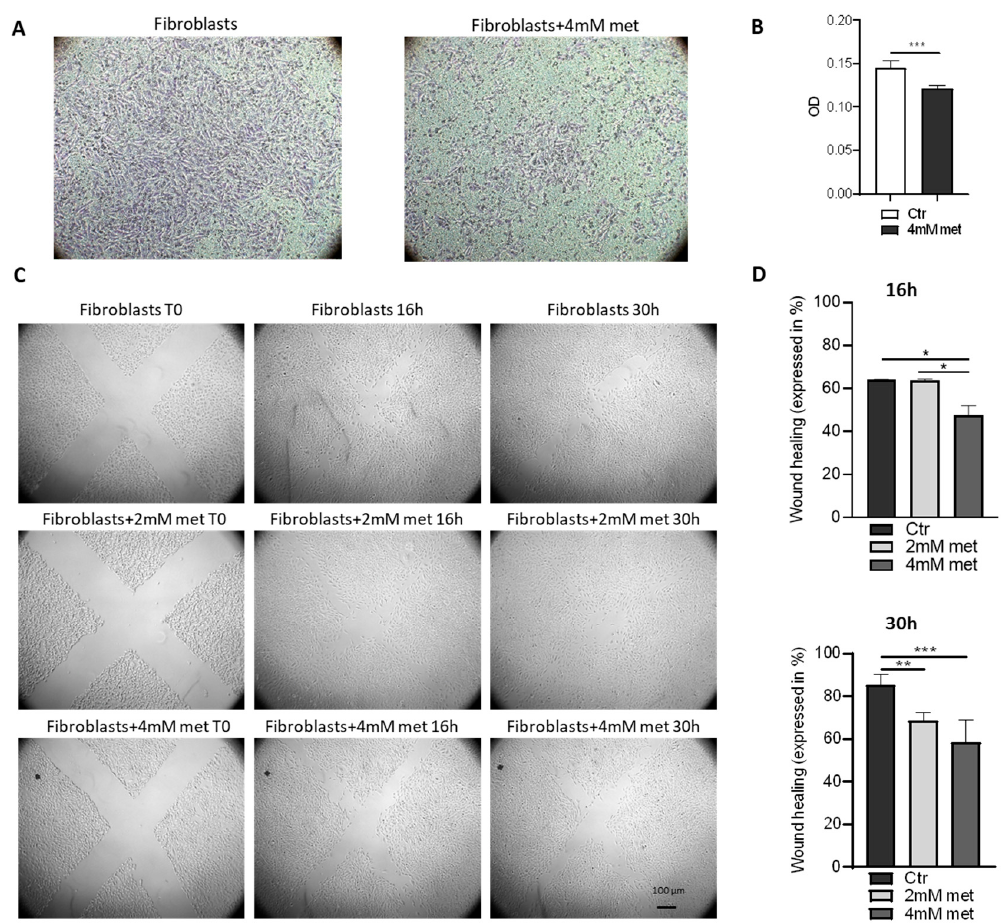
Figure 6. Effects of metformin on fibroblasts migration. ( A ) Fibroblast migration through 8 µ m porous transwell membranes in presence or not of 4 mM metformin for 30 h. Images are representative of migrating cells of three independent experiments, each performed in duplicate. ( B ) Quantification of fibroblast migration reported as optical density of crystal violet measurements. Fibroblasts treated with 4 mM of metformin (dark grey bar) migrated significantly less compared with their not treated counterpart (white bar). ( C ) Representative images of wound healing assay of fibroblasts treated or not with 2 mM or 4 mM of metformin. Images are representative of three independent experiments, each performed in triplicate. The efficiency of the healing was evaluated after 16 h and 30 h. ( D ) Histograms quantify the healing of the scratch areas by fibroblasts treated or not (black bars) with 2 mM (light grey bars) or with 4 mM of metformin (dark grey bars). Bar charts in ( B , D ) represent the media of three independent experiments ± SD. Asterisks indicate significance (* p < 0.05, ** p < 0.01; *** p < 0.001) by one tailed paired t-test.